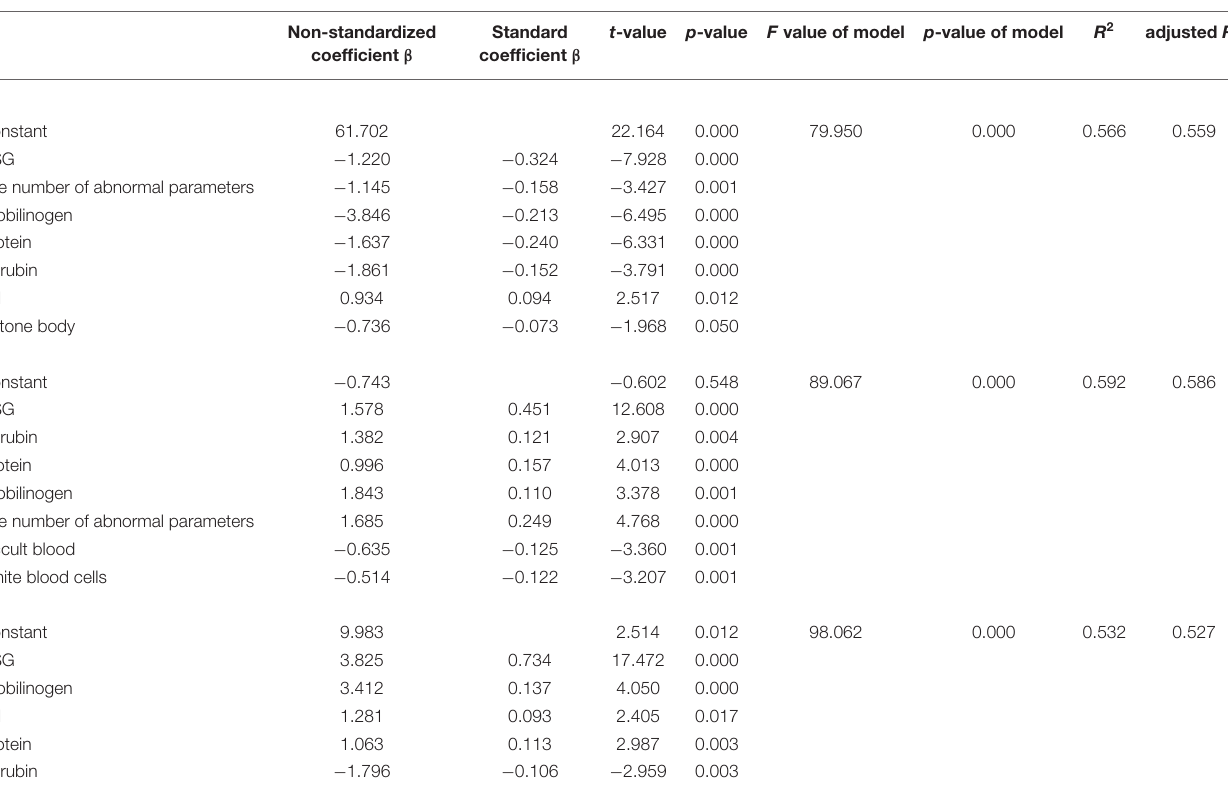
TABLE 6 | Stepwise regression analysis results of urine color and urine dry chemical parameters ( n = 437).